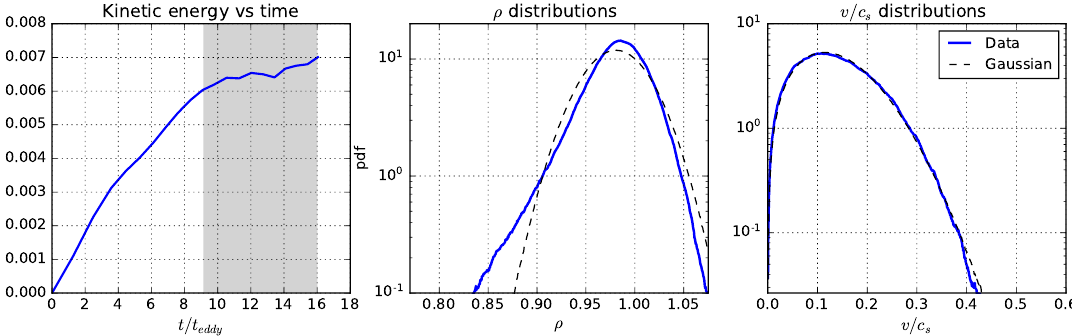
Figure 5 . (Left): average Newtonian speci(cid:12)c kinetic energy plotted as a function of dimensionless time for the direct-cascade simulation. The eddy turnover time is de(cid:12)ned as t eddy = 2 (cid:25)=! rms . The shaded region indicates the interval of time over which all other quantities are averaged. (Centre and right): probability distribution functions for the energy density (cid:26) (centre, blue, solid) and the Mach p number v=c s (right, blue, solid), where c s = c= 2, plotted on a semi-log scale. For comparison, purely Gaussian distributions are plotted (black, dashed) with the average and standard deviation matched to the data. The standard deviation of the (cid:26) and v=c s distributions are (0 : 0336 ; 0 : 0758), respectively. The rms Mach number is 0 : 11. These properties indicate a weakly compressible